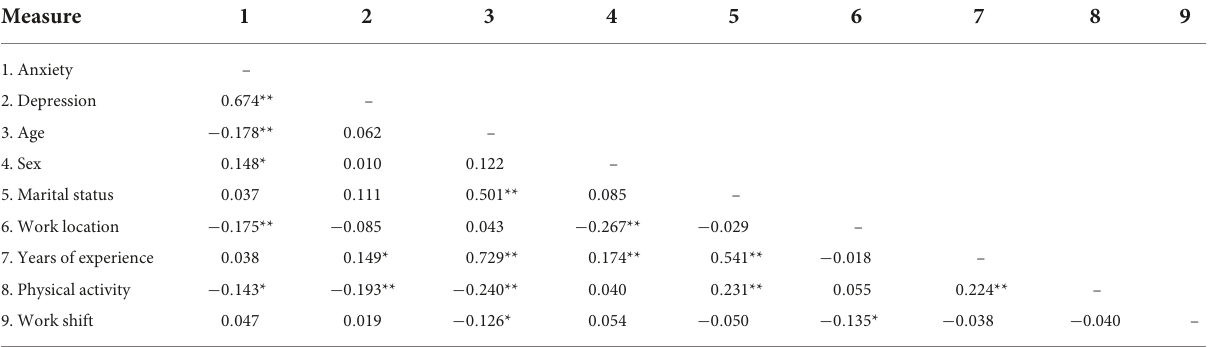
TABLE 4 Correlations among anxiety, depression, and participants